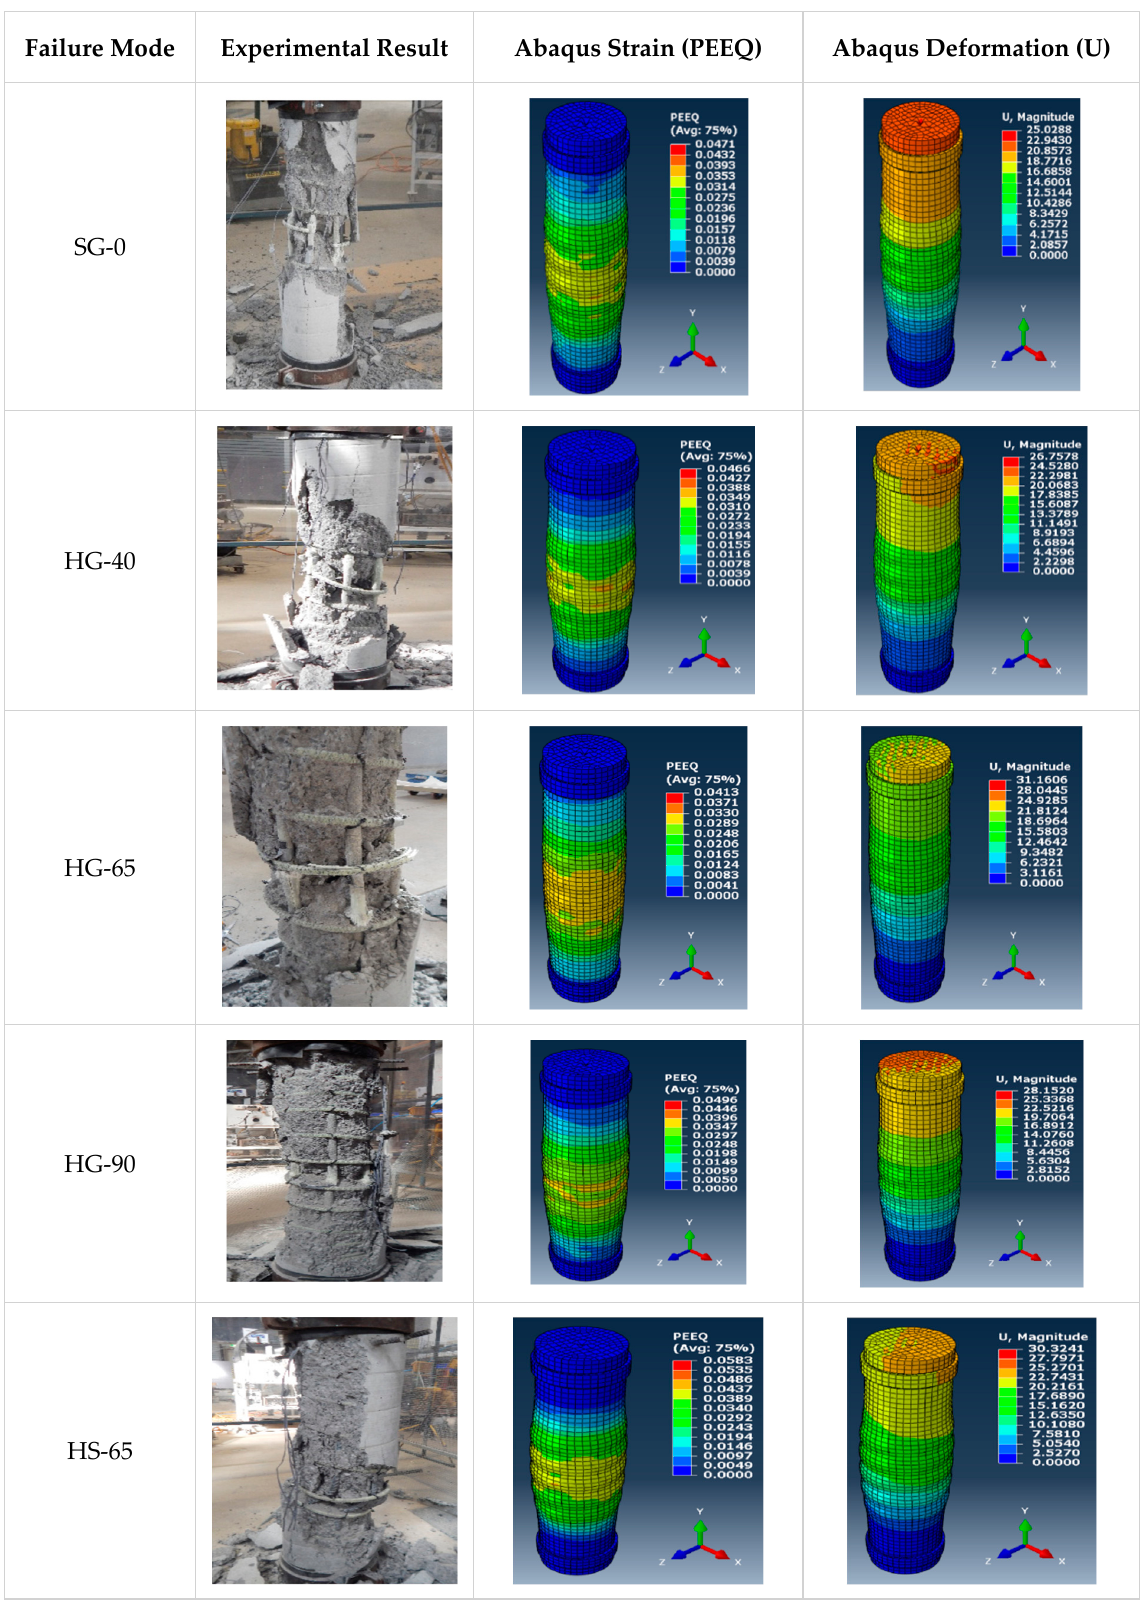
Figure 18. Failure modes of columns and their numerical representation.